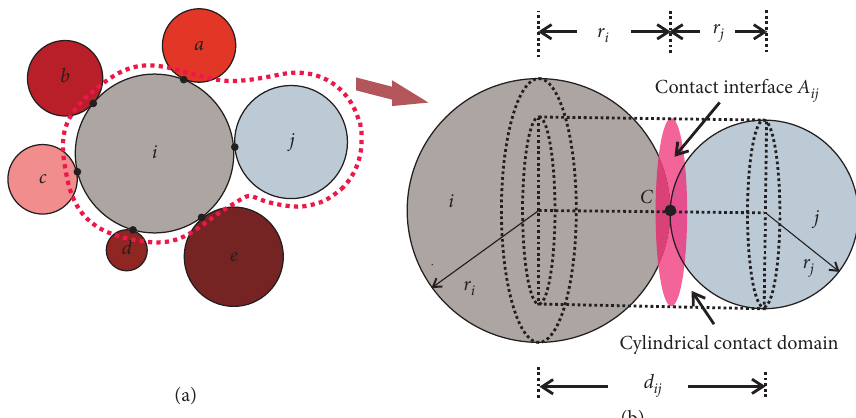
Figure 7: Schematic diagram of the contact relationship between the particles when the CPB is compressed. (a) The unit-body. (b) Two contacting particles in the